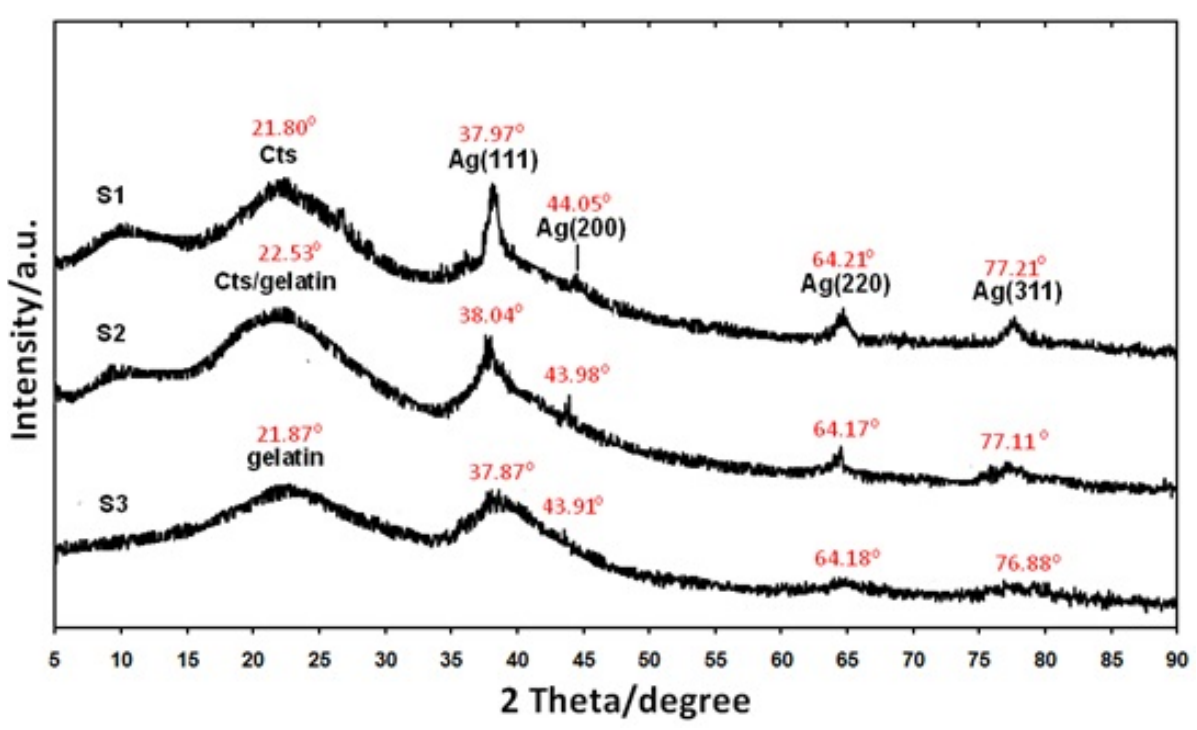
Figure 3. Powder X-ray diffraction patterns of Ag/Cts (S1), Ag/Cts/gelatin (S2) and Ag/gelatin (S3) BNCs for its crystals structure